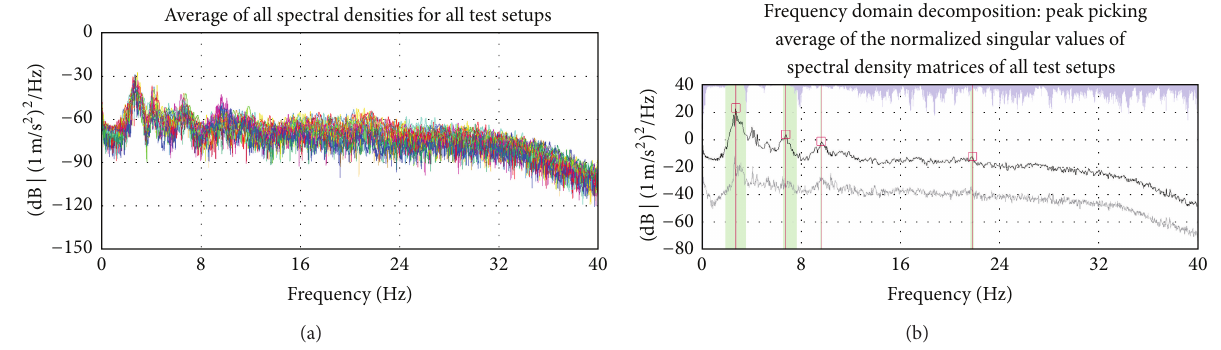
Figure 32: Dynamic characteristics attained from the test using PP and SSI method: (a) average of auto spectral densities and (b) singular values of spectral density matrices.